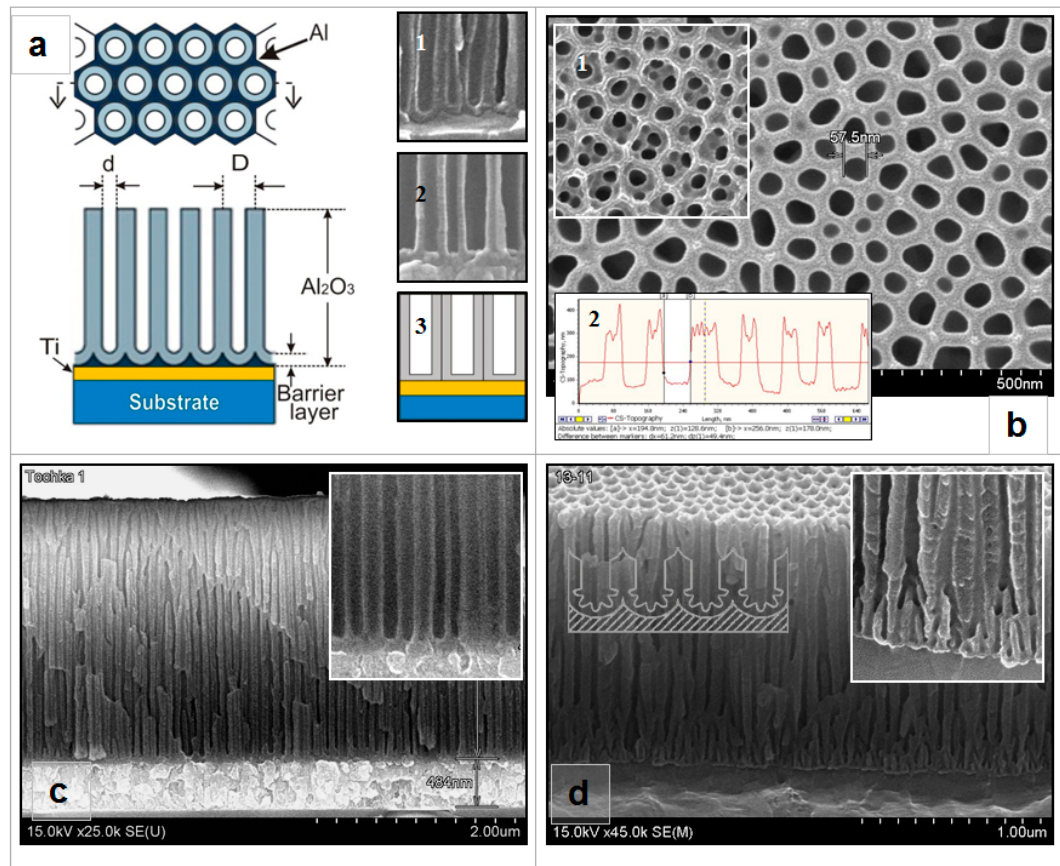
Figure 1. ( a )—Scheme of porous anodic alumina template (PAAT). The insets show the scanning electron microscopy (SEM) picture of a cross-section of the sample before (1) and after the etching of barrier layer (2), the scheme of this fragment cross-section (3). ( b )—Surface view and atomic force microscopy (AFM) profile (inset 2) of the experimental sample after barrier layer etching. Inset 1